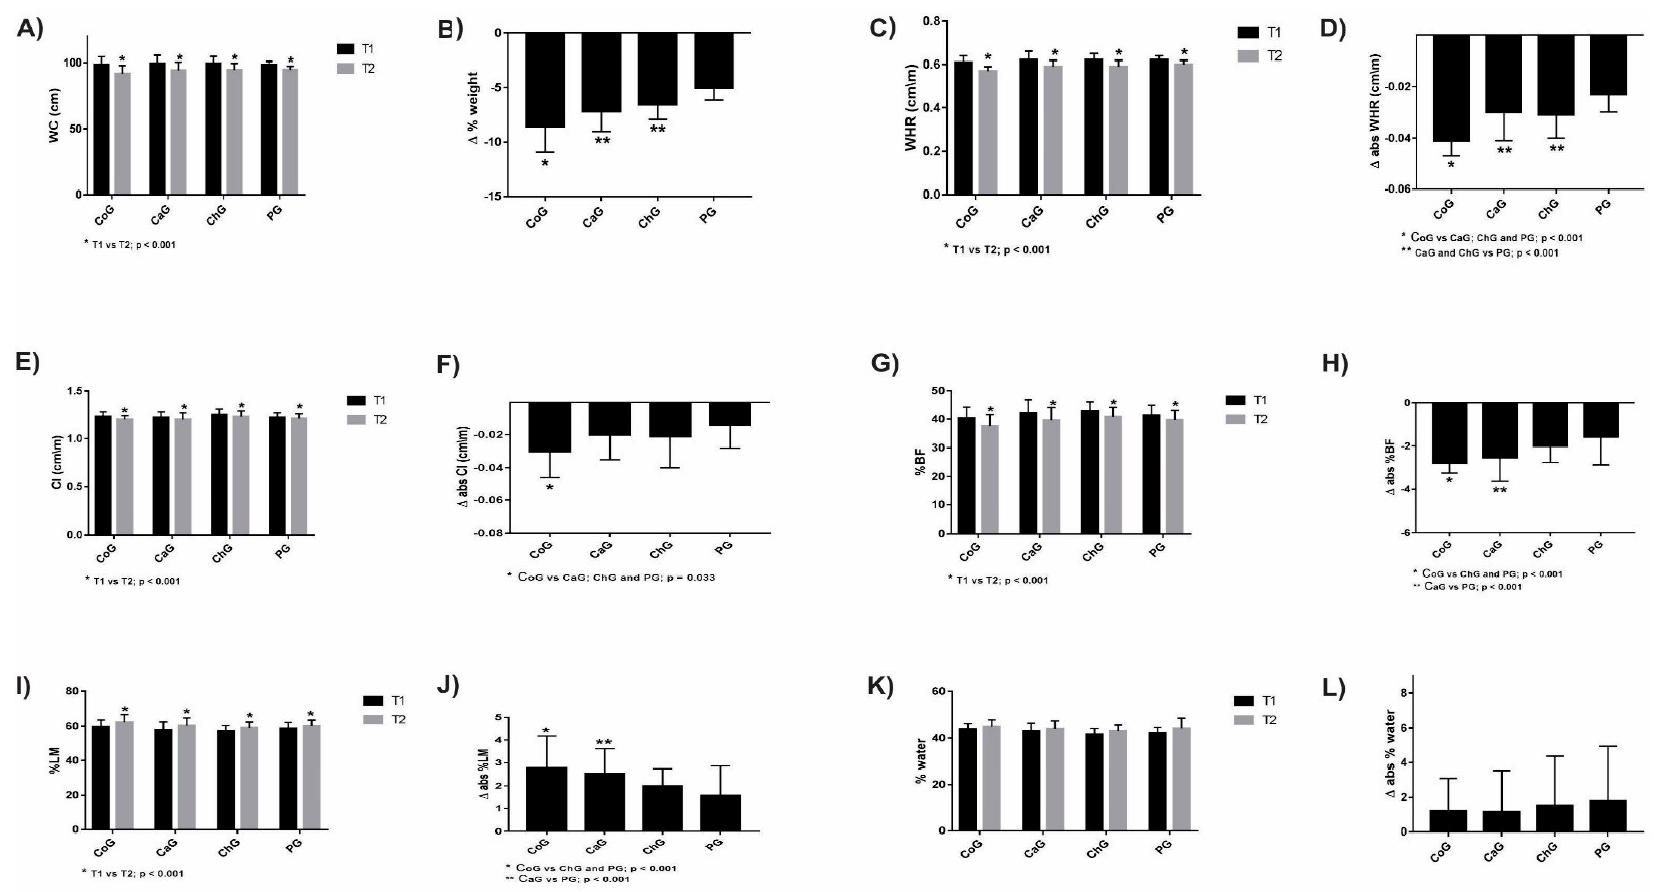
Figure 3. Anthropometric characteristics of participants before (T1) and after (T2) supplementation.T1 vs. T2: WC ( A ), WHR ( C ), CI ( E ),%BF ( G ), %LM ( I ), and %water ( K ). Absolute variation (T1 vs. T2) of WC ( B ), WHR ( D ), CI ( F ), %BF ( H ),%LM ( J ), and %water ( L ). WC—waist circumference; WHR—waist-to-height ratio; CI—conicity index; %BF—body fat percentage; %LM—lean mass percentage; %water—percentage of hydration; CoG—Group supplemented with coconut oil; SafG—Group supplemented with safflower oil; ChG—Group supplemented with chia oil; PG—Group supplemented with soybean (placebo) oil. Results presented as mean + standard deviation (SD).